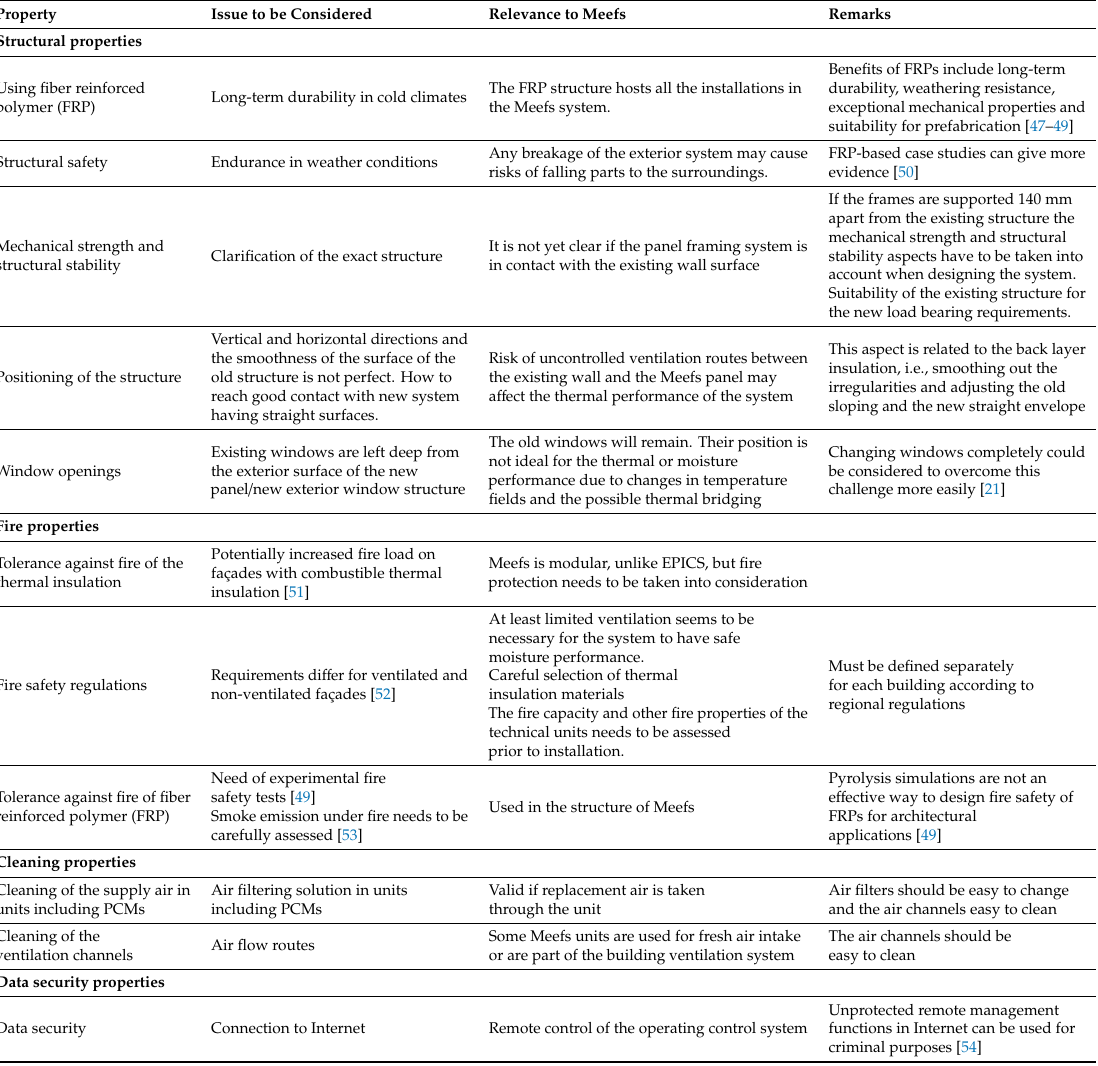
Table 2. An assessment of other properties of the Meefs